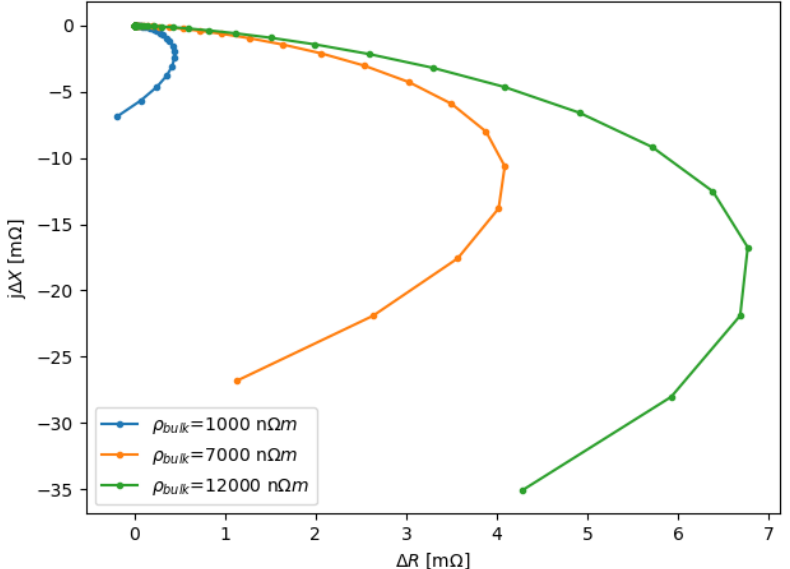
Figure 15. Simulated coil response for variable bulk resistivity. We assume a bulk of 1.5 mm thickness, and a coating of 6 µ m thickness with resistivity of 50 n Ω m. The lift-off is 0.7 mm. The procedure was used to characterize Mo-coated samples on MoGr and graphite